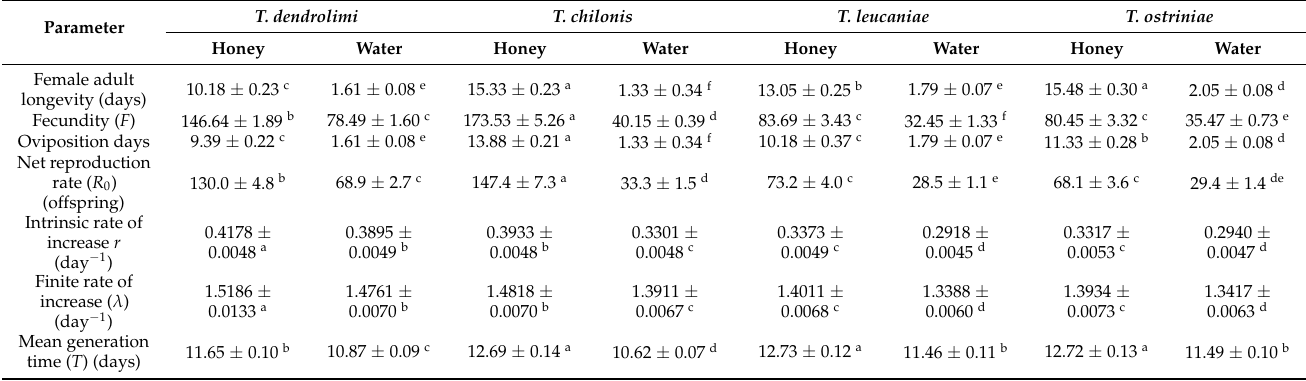
Table 1. Parameters of four Trichogramma species fed with honey solution and water parasitizing on Corcyra cephalonica